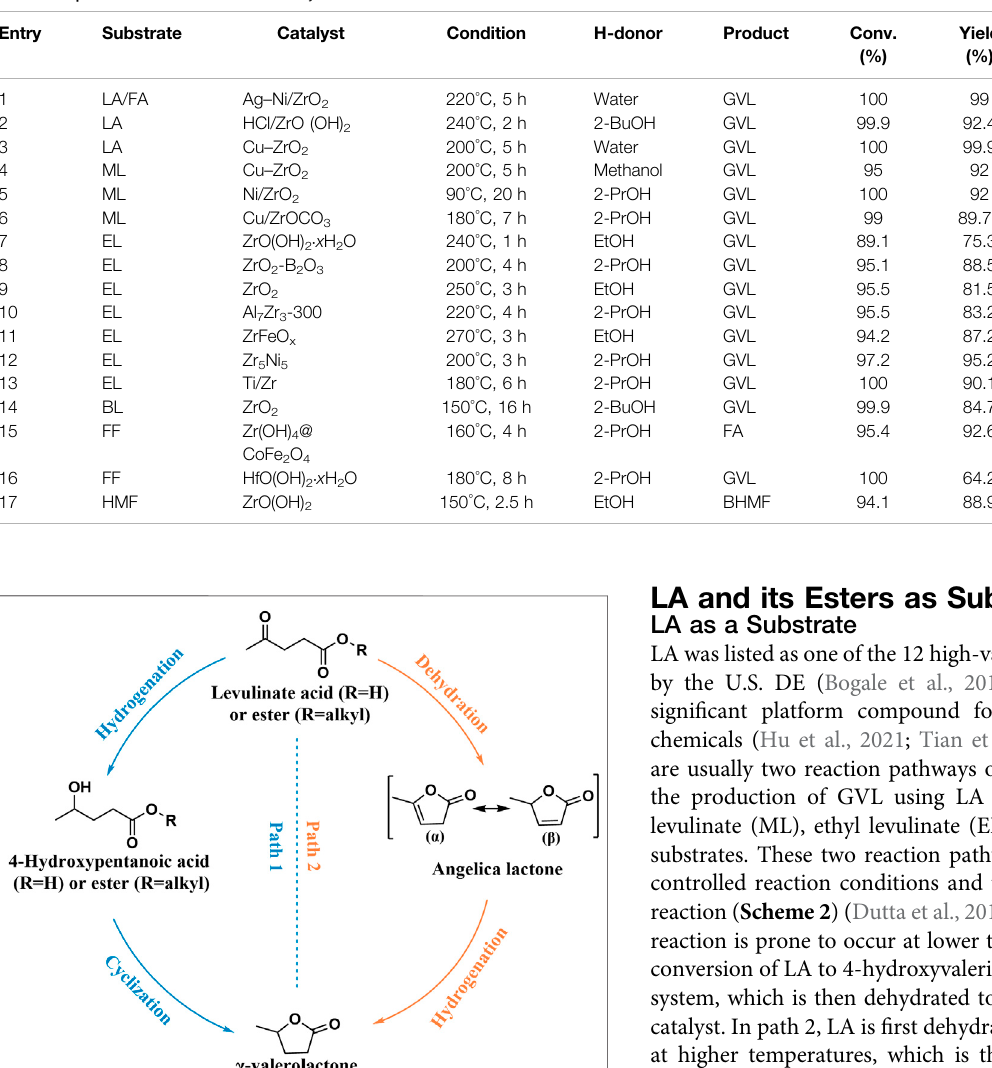
TABLE 1 | Zr/Hf-based metal oxide